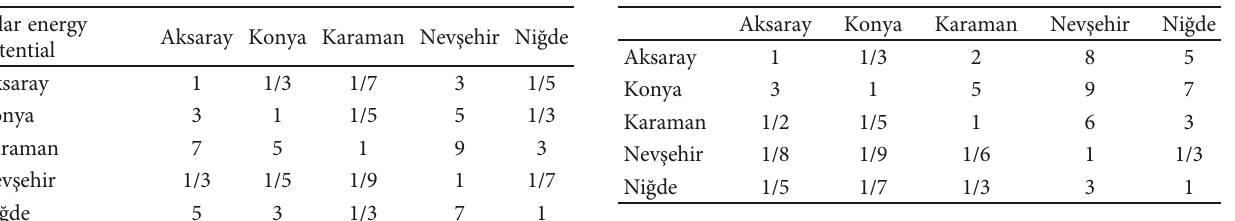
Table 3: Comparison matrix for solar energy potential.